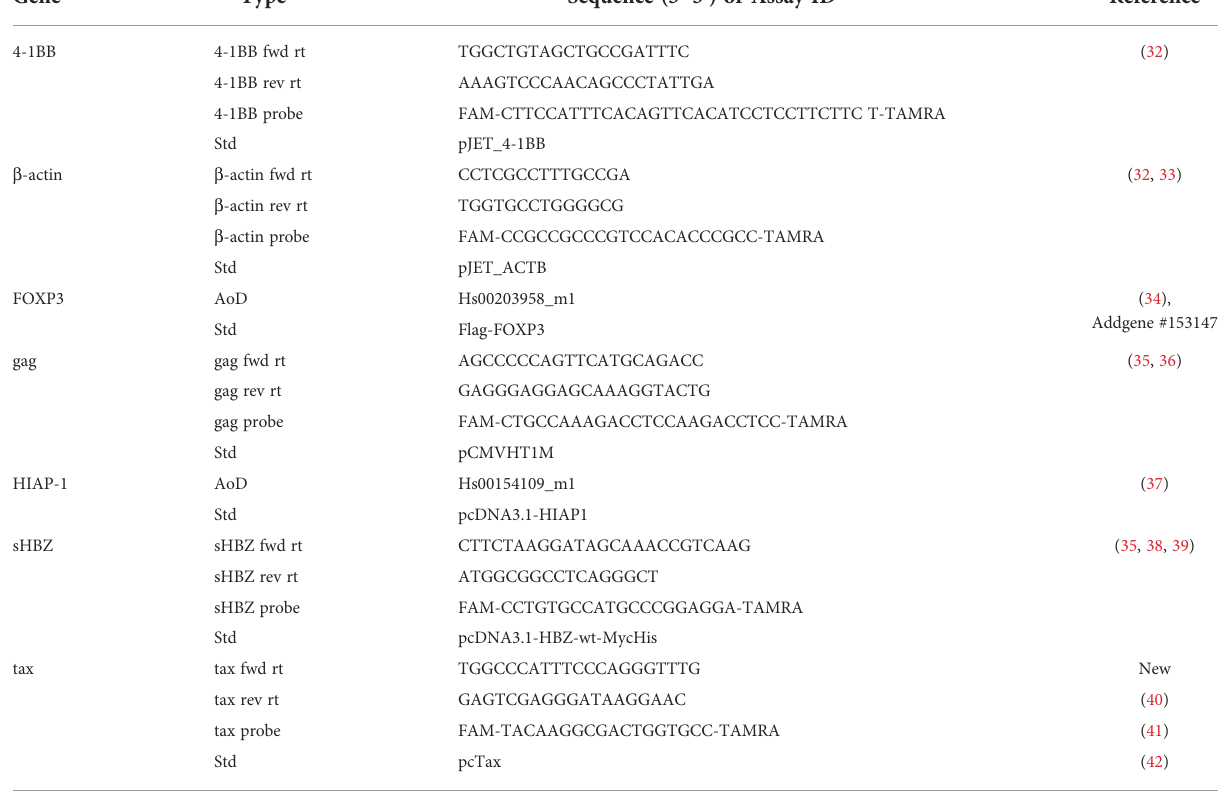
TABLE 1 Sequences of oligonucleotides for qRT-PCR